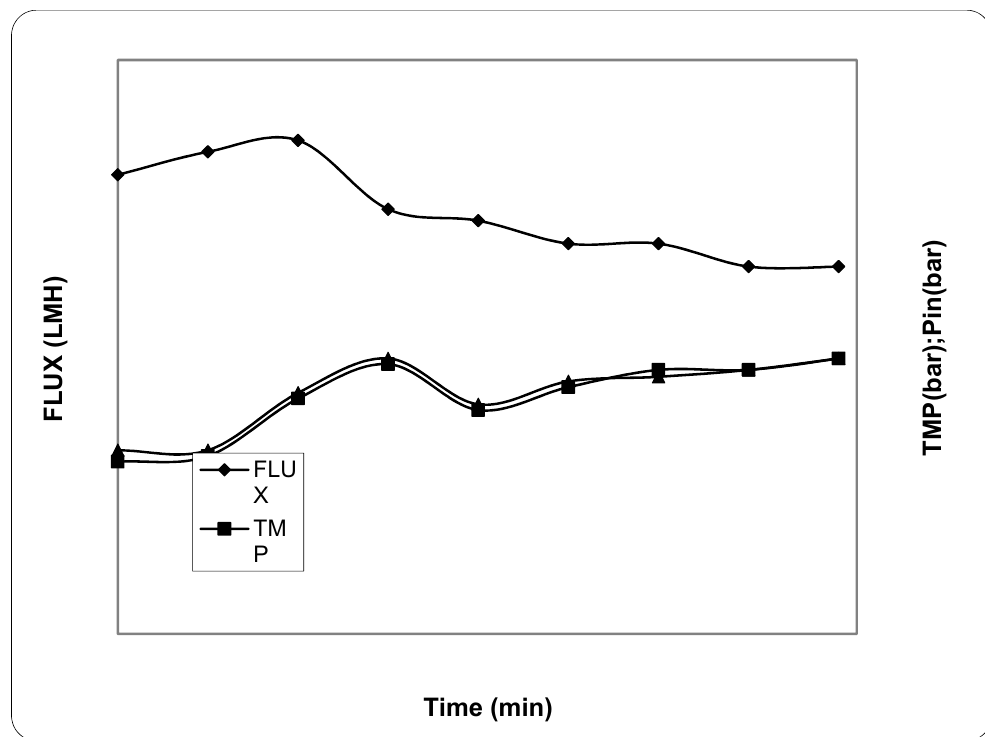
Figure 6. Transmembrane flux, corresponding TMP, and inlet pressure during the nano filtration treatment. The experiments were performed in triplicate.